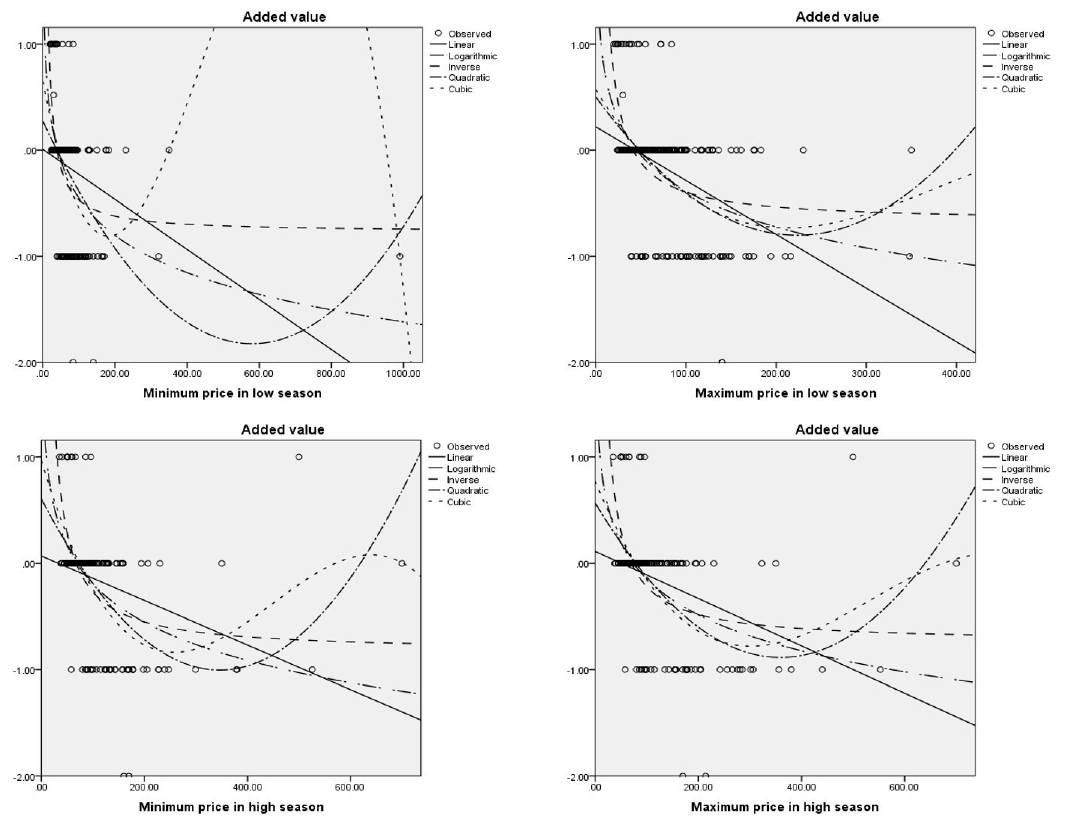
Figure 2. Functions of the regression analysis with the best fit in the Gran Canaria destination.